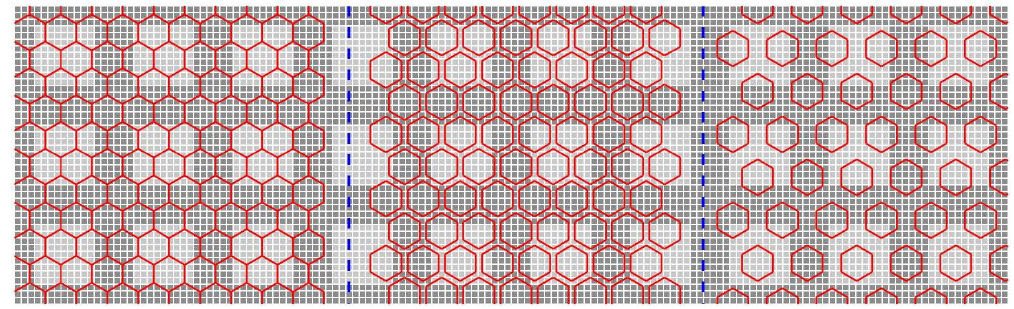
Figure 13. One example of the hexagonal sensor having the gap factor of 0%, 20% and 60% from left to right, and the pixel size is kept the same.